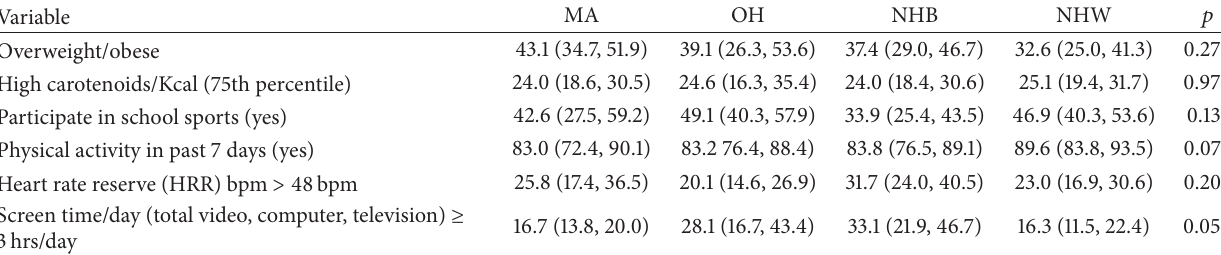
Table 1: Overweight/obesity characteristics by race/ethnicity in percent (95th CI).